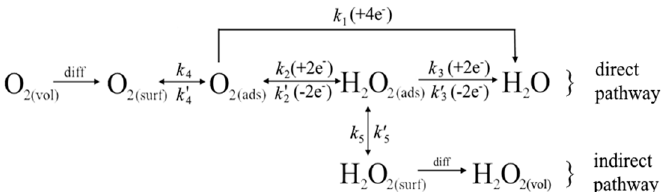
Figure 1. Simplified scheme of the ORR with direct and indirect pathways. In the scheme: k i and k ’ i are the reaction rate constants at various stages of the process in the forward and reverse directions, respectively.